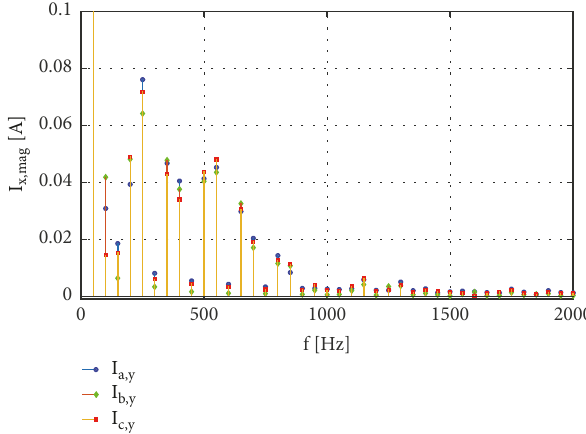
Figure 5: Harmonic content of the three-phase currents where y ∈ [1..40] -IEC61000-3-2.